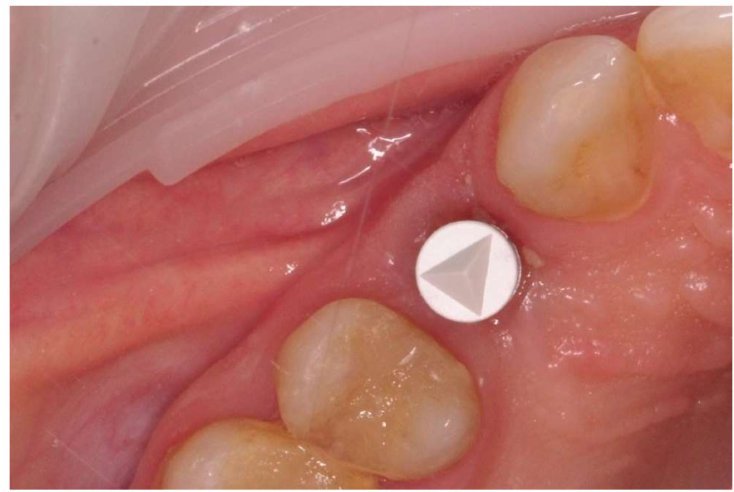
Figure 2. Implant with scanbody prepared for intraoral